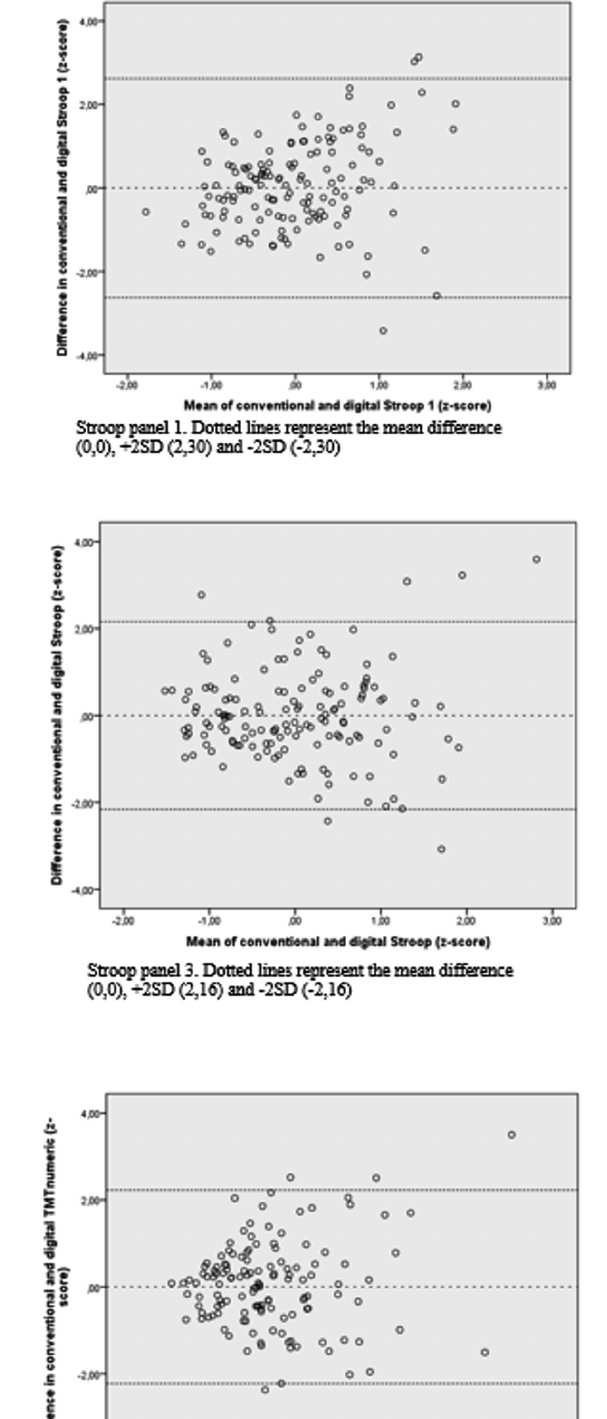
Figure 3. Systematic differences between conventional and smartphone-based cognitive tests in a Bland-Altman-plot. All values are standardized in